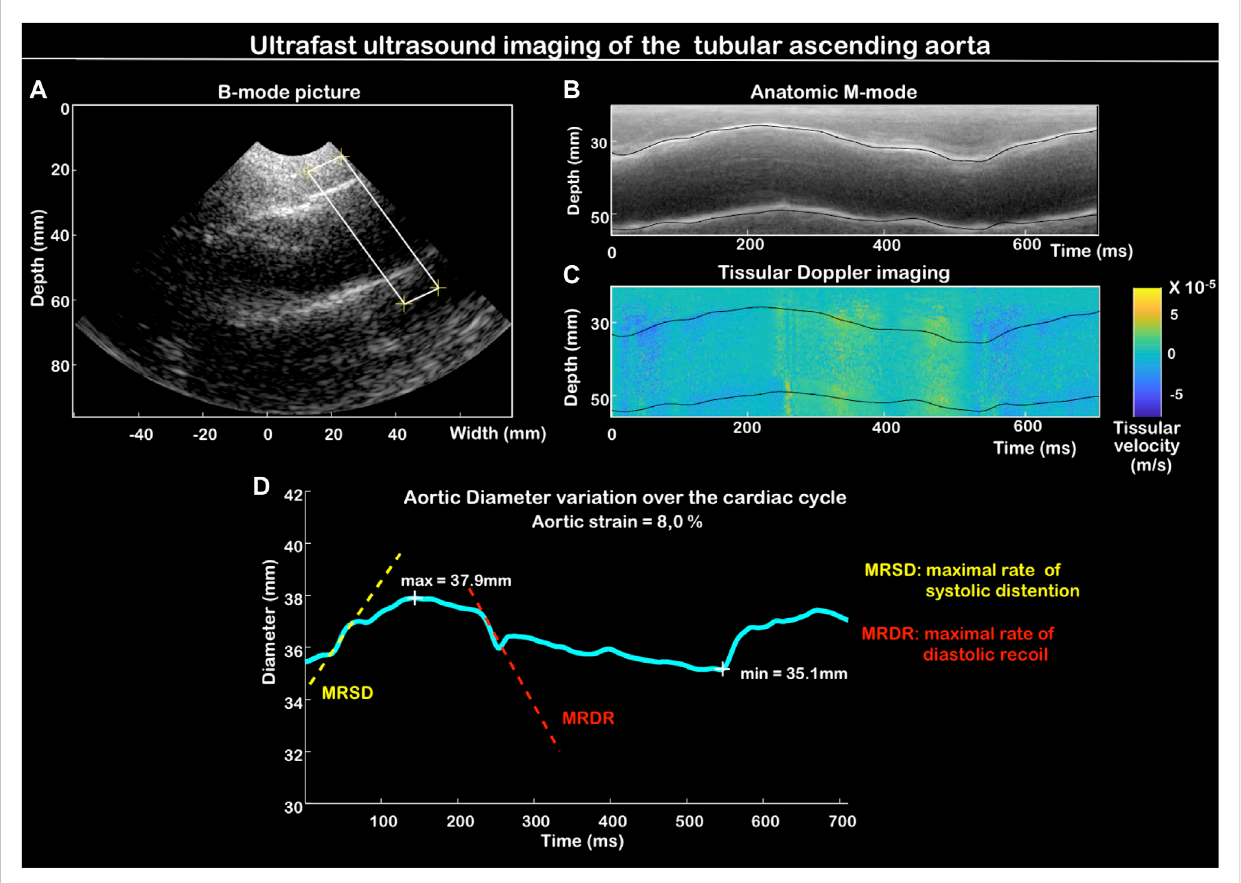
FIGURE 2 Aortic distensibility measurement method: delimitation of the area of interest of the aorta on the B-mode image. Here at the level of the sinus of Valsalva (A) . Automated wall delineation from the anatomic M-mode (TM image) of the delineated segment (B) . Collecting tissue velocity values (Tissue Doppler imaging) for each aortic wall over time (time) (C) . Determination of the aortic diameter variation curve over time (D)